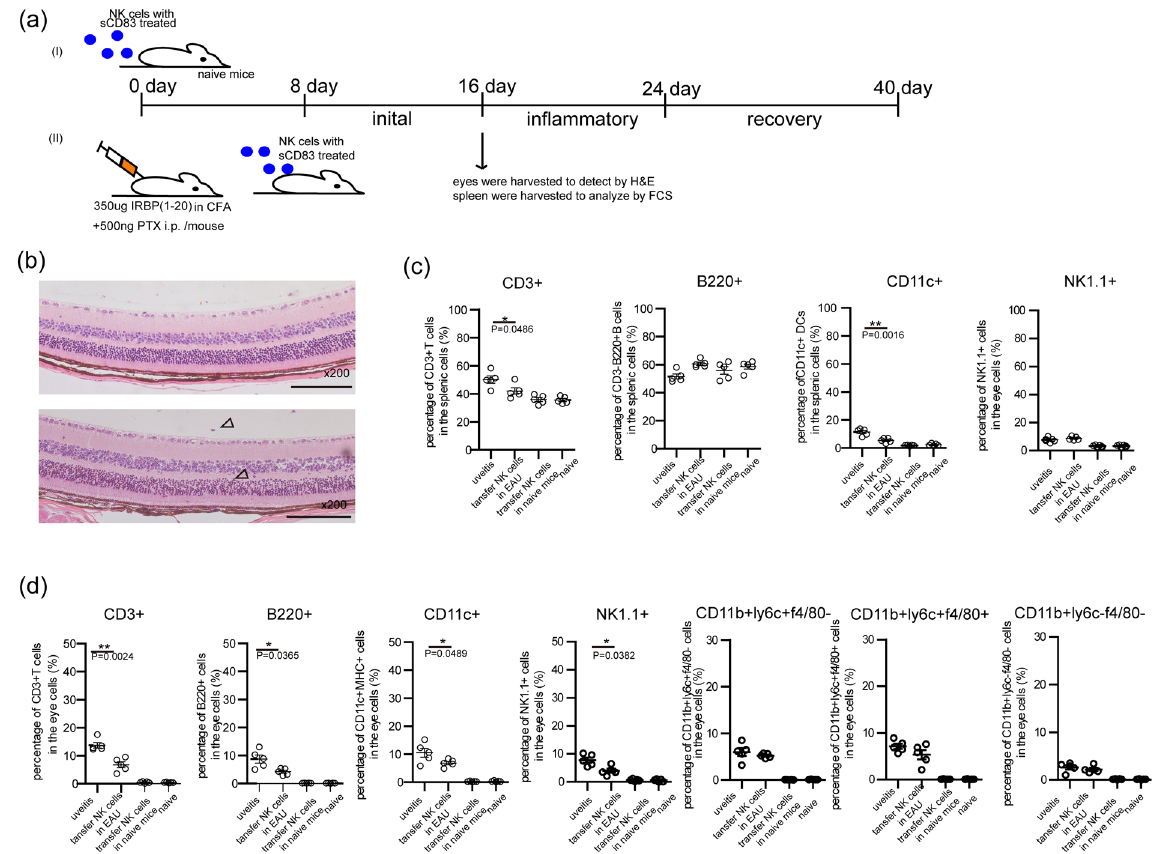
Figure 6. Reductions in symptoms and the number of lymphocytes in EAU mice by sCD83-treated-NK cells. ( a ) C57BL/6 Mice were immunized on day 0 and sCD83 treated-NK cells were transferred into mice by intravenous injection. At 16 days after immunization, eyes of the mice receiving or not a transfer of NK cells were harvested for H&E staining. Eyes and spleen were also harvested from untreated naïve mice that received a transferred by sCD83 treated-NK cells for H&E staining. ( b ) Pathological changes of inflamed eyes from EAU and naive mice receiving a transfer of sCD83 treated-NK cell. Some infiltration of lymphocytes and slight photoreceptor folding were observed in the eyes of EAU mice receiving sCD83 treated-NK cells (hollow arrows). ( c ) Subsets of lymphocytes from the spleen of EAU and naive mice receiving or not sCD83 treated-NK cells. ( d ) Subsets of lymphocytes in the eyes of EAU and naïve mice receiving or not sCD83 treated-NK cells. (A total of five mice/group were used for three separate experiment, values represent the mean ± s.e.m., * P < 0.05, ** P <